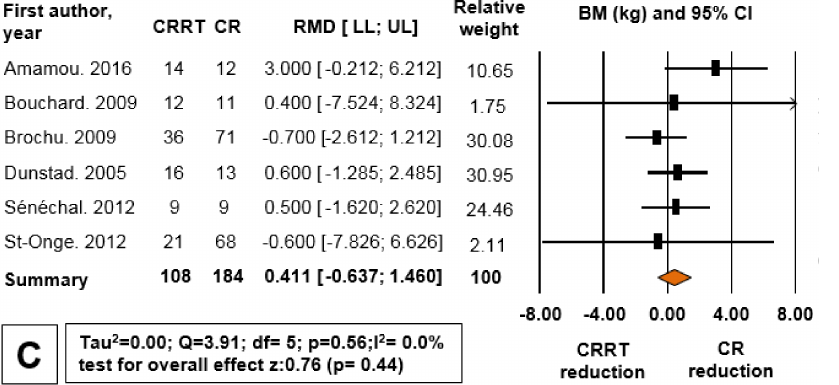
Figure 2. Forest plot for differences between caloric restriction plus resistance training (CRRT) and caloric restriction (CR) reductions of LBM ( A ); FBM ( B ); and BM ( C ). RMD: raw mean difference (kg); LL: lower limit of 95% CI; UP: upper limit of 95% CI; CI: confidence interval.